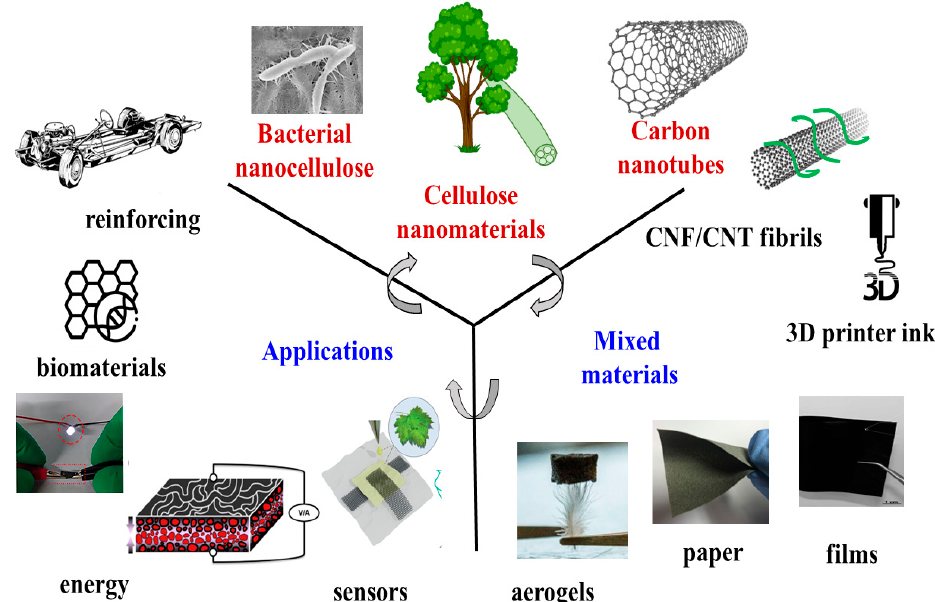
Figure 10. Diagram showing recycling from mixed materials of nanocellulose and CNTs to applica- tions. Adapted from [34].